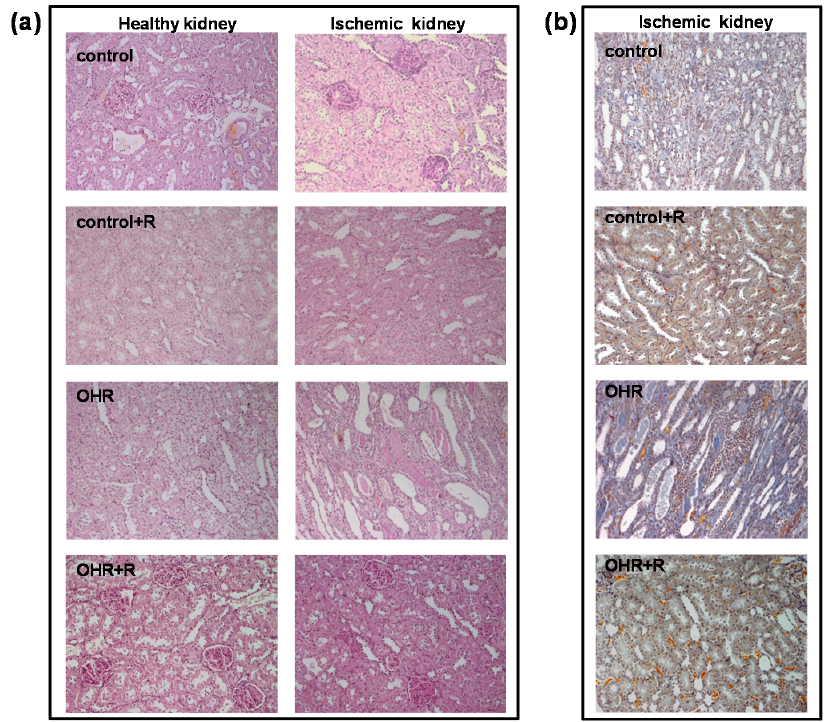
Figure 5. Representative PAS ( a ) and trichrome ( b ) staining images (magnification 200×) of renal sections from control and OHR rats. The histological analysis indicated the appearance of morphological alterations, including mesangial hypercellularity, mesangial matrix expansion, tubular casts, tubular dilation, interstitial infiltration, and interstitial fibrosis. These alterations were more evident in ischemic kidneys of OHR rats compared to controls and were reverted by rostafuroxin treatment. The evaluation of histological parameters was scored semi-quantitatively as shown in Table 3. The glomerular evaluation was performed on 30 glomeruli per section, indicating that it was modestly affected by ischemia and rostafuroxin (score in Table 3).